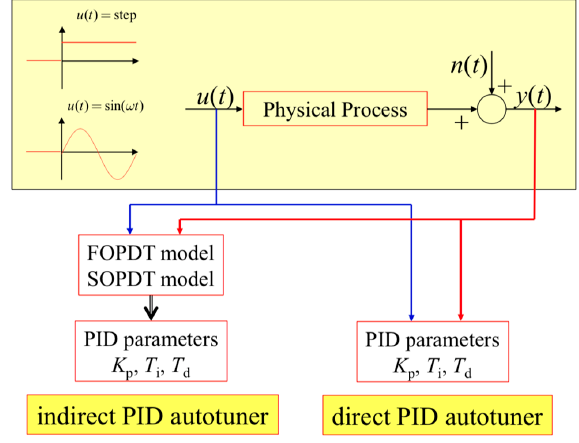
Figure 1. Autotuning approaches.